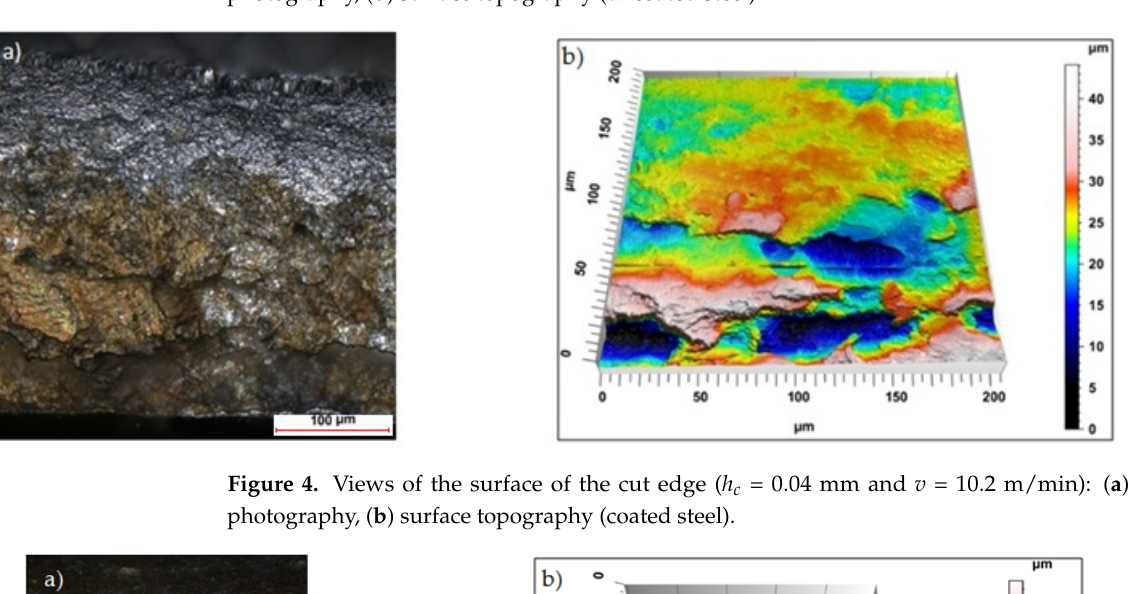
Figure 3. Views of the surface of the cut edge ( h c = 0.04 mm and v = 10.2 m/min): ( a ) surface photography, ( b ) surface topography (uncoated steel).